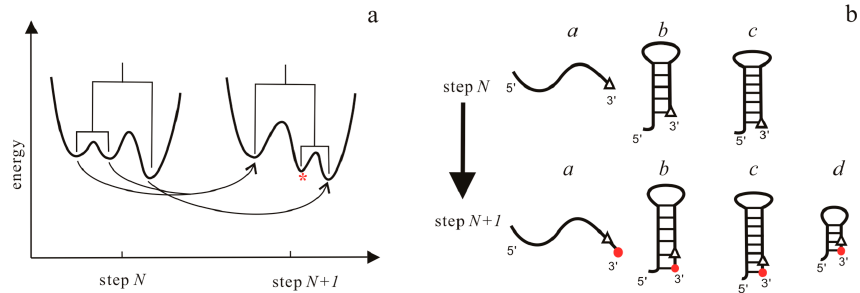
Figure 4. Relationship of landscapes in the BarMap approach ( a ) and structures in the helix-based computational method ( b ) between two adjacent steps. In ( a ), there are three types of events in landscapes: (i) A one-to-one correspondence between two minima (right); (ii) A two-to-one correspondence (left); and, (iii) a new local minima (marked by *) appears in the landscape at step N + 1. In ( b ), the triangles and red dots denote the newly transcribed nucleotide at step N and N + 1, respectively. For structures belonging to the first three types, their initial population at step N + 1 “directly inherit” from step N , while for type d , the initial population of the structure at step N + 1 is zero.